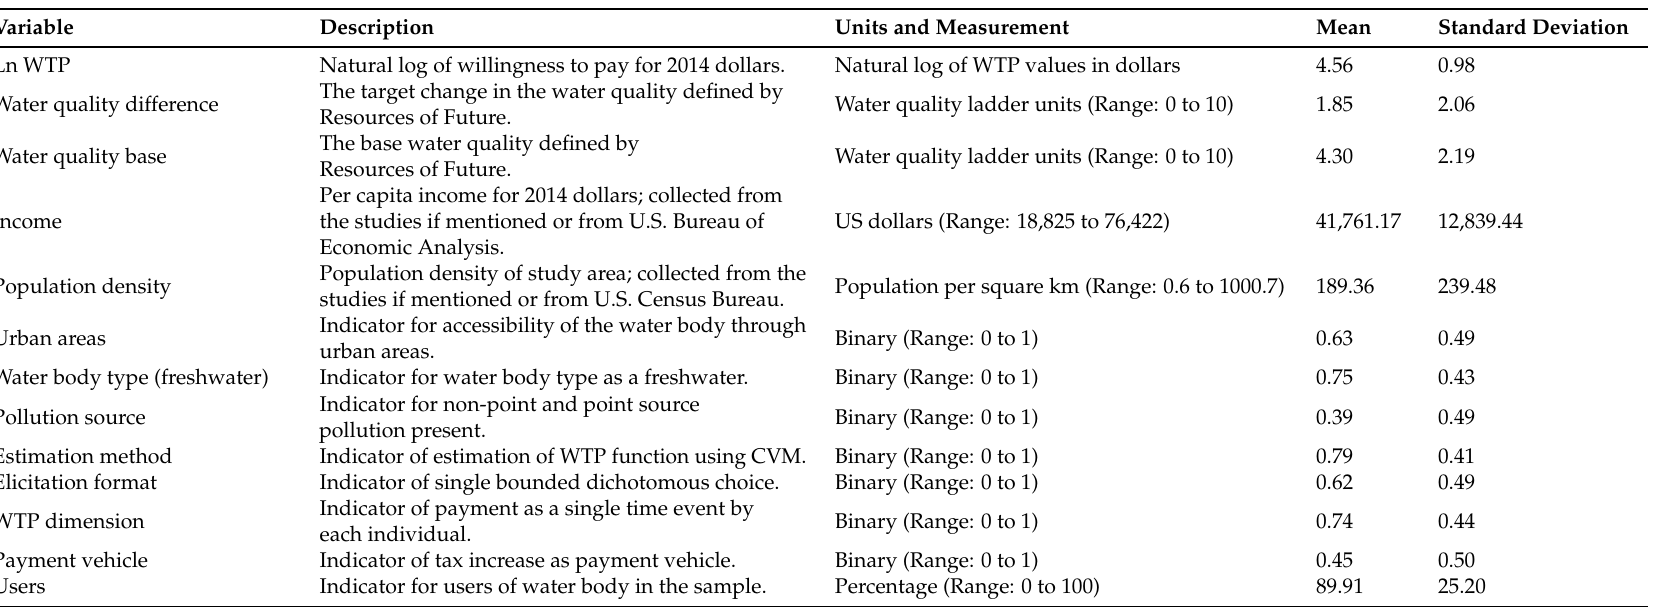
Table 2. Meta analysis variables and descriptive